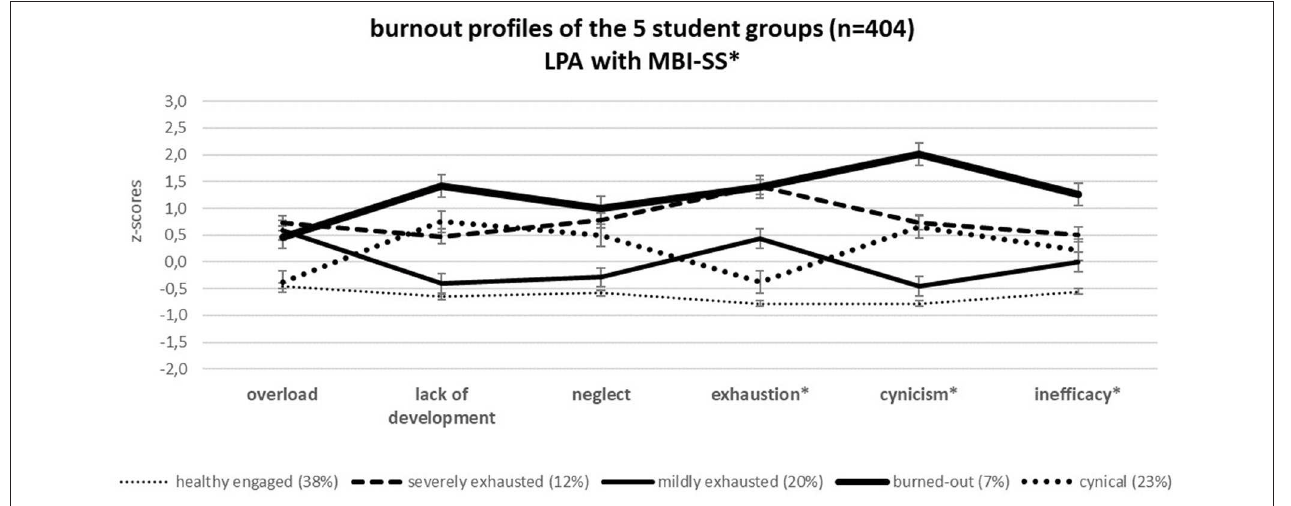
FIGURE 5 | Burnout characteristics of the five MBI-SS classes in the entire